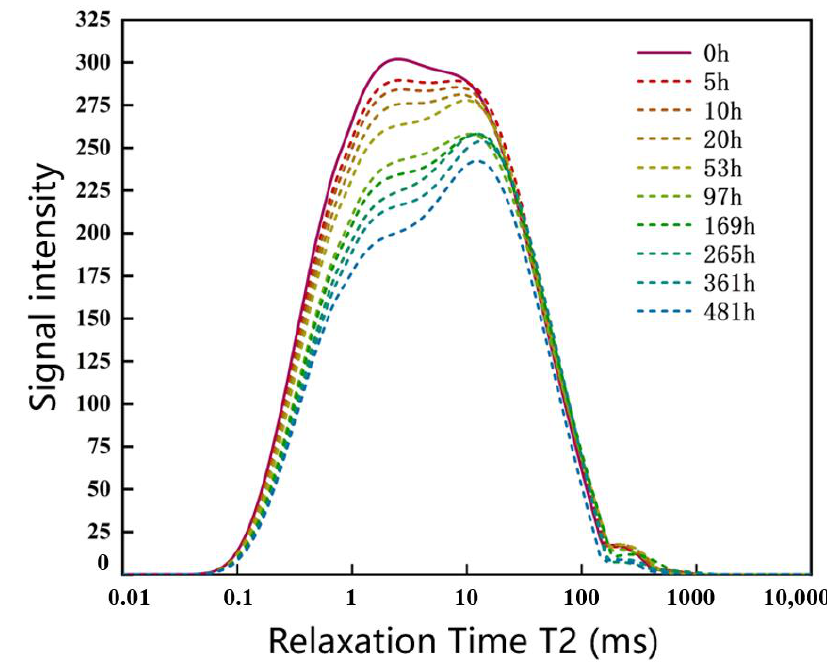
Figure 14. Development of T 2 of sample YSS under 10 MPa.